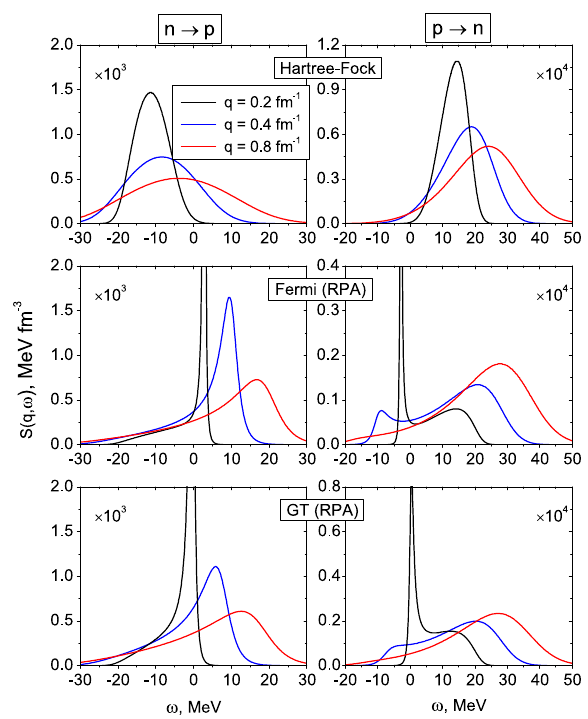
Figure 2. (Color online) Finite temperature ( T = 8 MeV) strength functions calculated with the LNS Skyrme potential at three val- ues of momentum transfer. The density and the proton fraction are the same as in Fig.